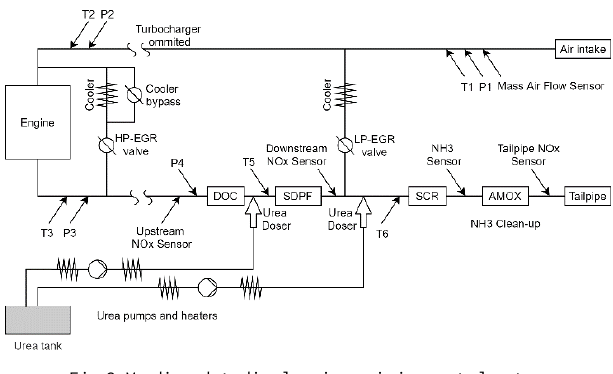
Fig. 2. Medium-duty diesel engine emission control